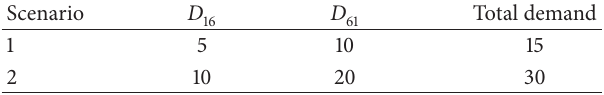
Table 1: Travel demand scenarios for the 16-link network.